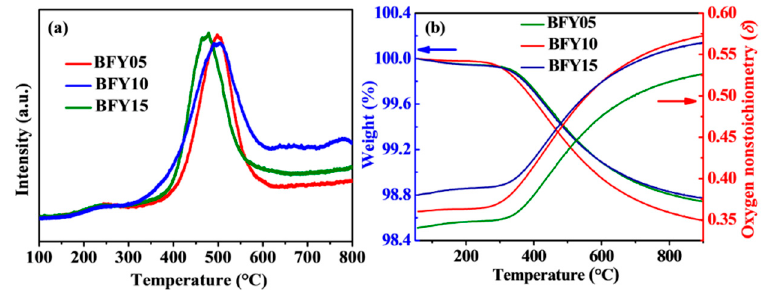
Figure 2. ( a ) TPD curves of BFY x samples measured from 100 to 800 °C; ( b ) TG curves and oxygen non-stoichiometry ( δ ) of BFY x between 50 and 900 °C.